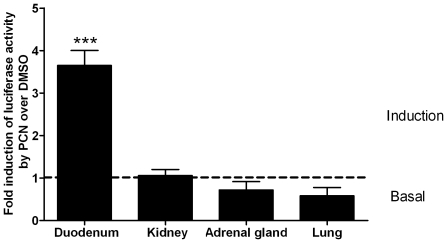
The effect of PCN on the expression of firefly luciferase driven by 6.2 kb of a human CYP3A5 promoter in the duodenum, kidney, adrenal gland, and lung of transgenic mice.Mice (3 males and 3 females per treatment group) were injected i.p. with PCN (50 mg/kg) or the DMSO solvent. Organ homogenates were assayed with luciferase reporter gene assay (Promega) using a luminometer. Data are represented as ratio of RLU per µg protein of PCN over DMSO, shown as mean values (± SEM). Statistically significant differences are indicated by asterisks (*** p<0.001).